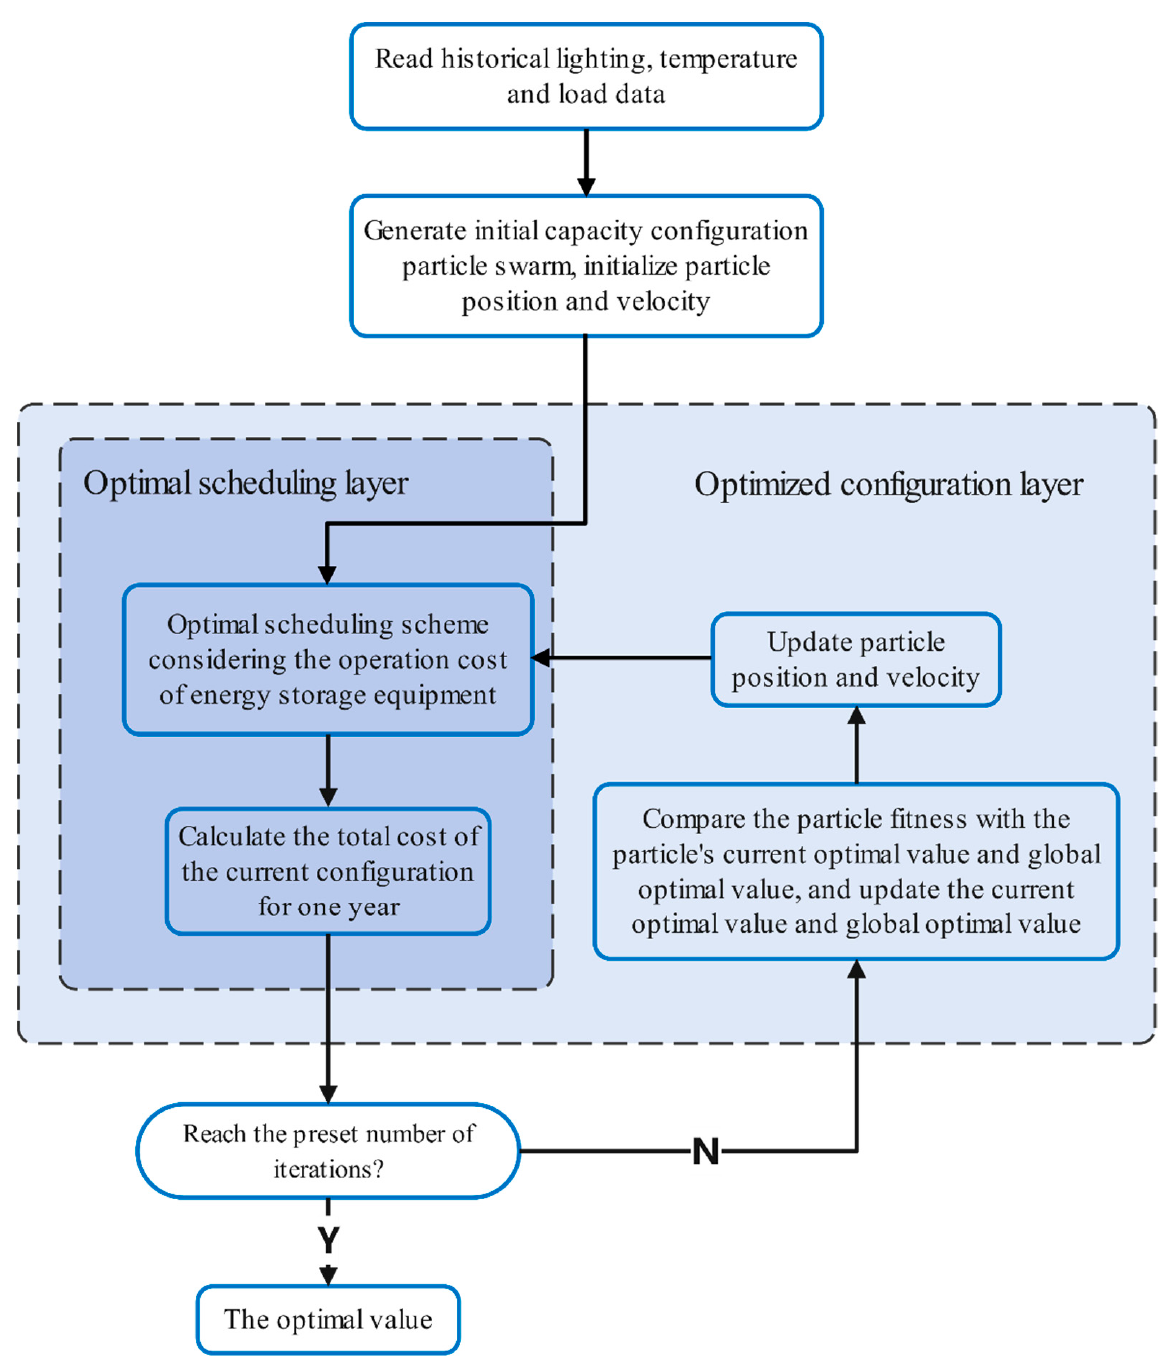
Figure 4. Optimal configuration process of microgrid source storage capacity.